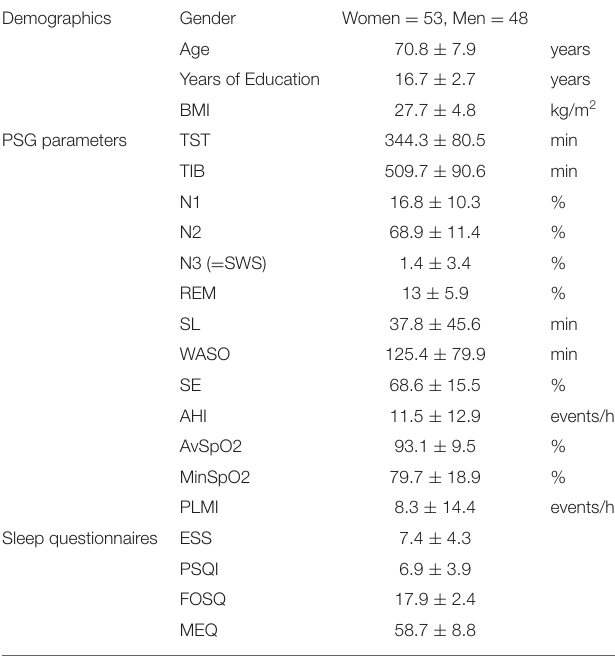
TABLE 1 | Mean and standard deviation of demographic characteristics, PSG parameters, Sleep questionnaires, and list-learning scores in all 101 participants. Demographics